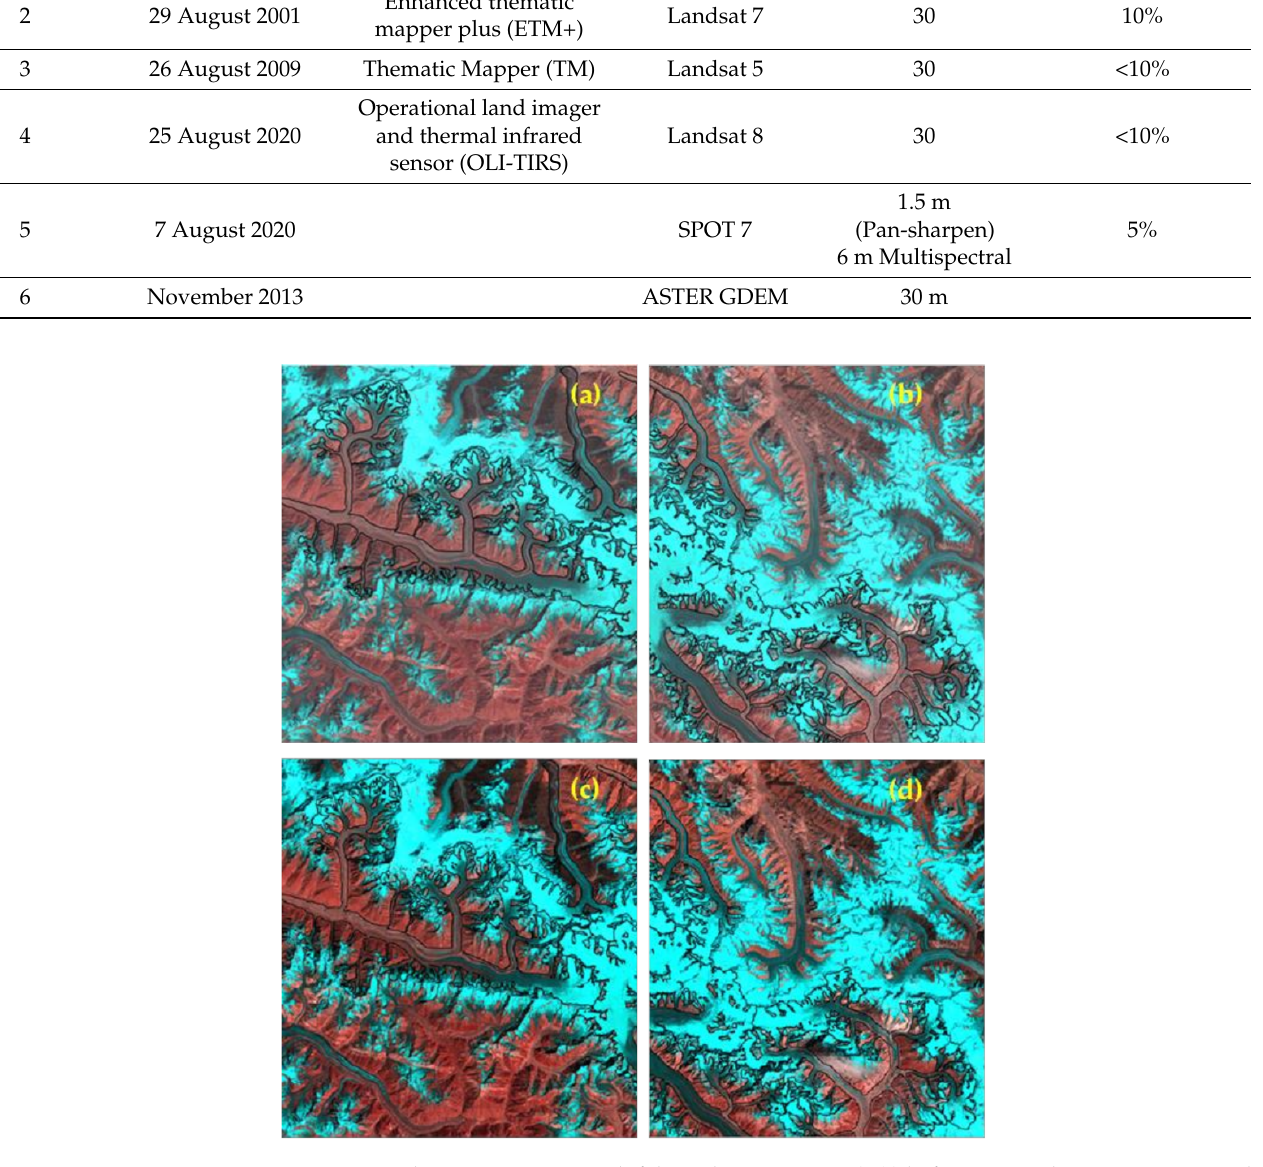
Figure 4. Landsat 8 OLI image with false color composite ( a , b ) before atmospheric correction and ( c , d ) after atmospheric correction. The image also shows much less cloud cover over the study